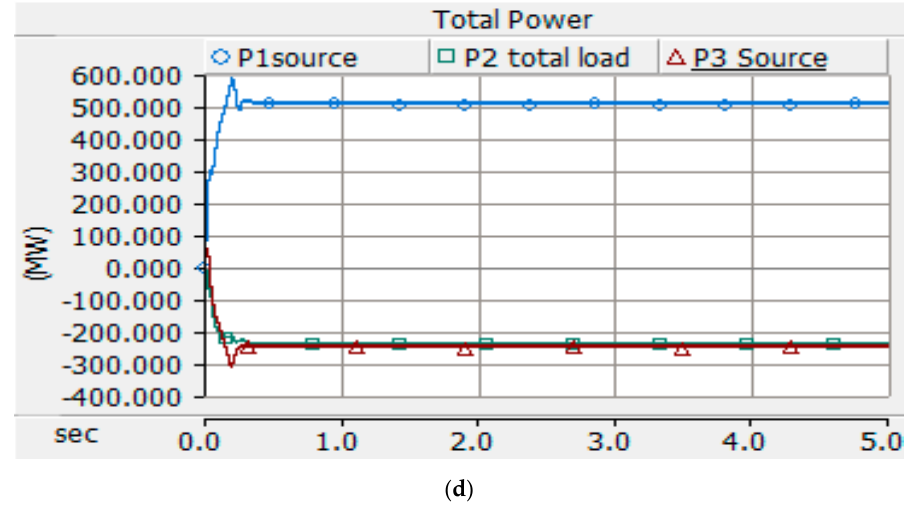
Figure 13. Simulated results for case 2. ( a ) DC terminal voltages of VSC1, VSC2, and VSC3. ( b ) Power measured on AC side of VSC1, VSC2, and VSC3. ( c ) Power measured on DC side of VSC1, VSC2, and VSC3. ( d ) Total power in area-1, area-2, and area-3.